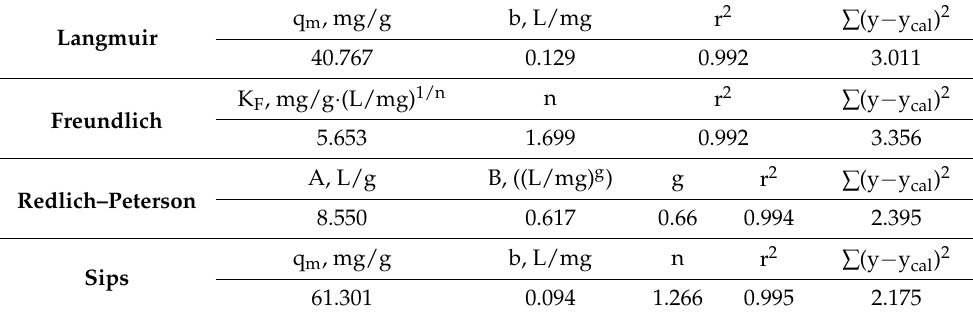
Table 7. Fit parameters of the experimental results to the different equilibrium models. q m , mg/g b, L/mg r 2 ∑ (y − y cal ) 2 Langmuir 40.767 0.129 0.992 3.011 K F , mg/g · (L/mg) 1/n n r 2 ∑ (y − y cal ) 2 Freundlich 5.653 1.699 0.992 3.356 A, L/g B, ((L/mg) g ) g r 2 ∑ (y − y cal ) 2 Redlich–Peterson 0.617 0.66 0.994 2.395 q m , mg/g b, L/mg r 2 Sips